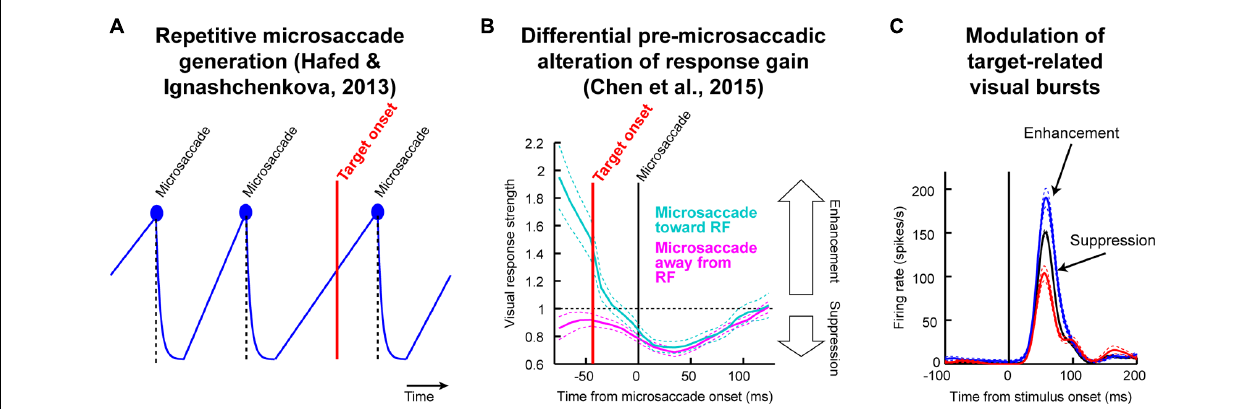
FIGURE 1 | Testing the theoretical implications of pre-microsaccadic changes in visual sensitivity. (A) During prolonged gaze fixation, microsaccades repetitively occur. This can be modeled as a repetitive rise-to-threshold process (Hafed and Ignashchenkova, 2013). If a peripheral target were to appear at a random time, it would necessarily appear at different times relative to microsaccade onset. (B) Peripheral target onset near microsaccades experiences altered visual sensitivity (Chen et al., 2015). Importantly, this effect is directionally dependent in the pre-movement interval (Hafed, 2013; Chen et al., 2015), such that visual sensitivity is enhanced if a target appears congruent with the upcoming microsaccade direction and suppressed if it is opposite the upcoming microsaccade. (C) The net result is that for an identical target onset, visual bursts can be either enhanced or suppressed as a function of microsaccade direction. Since response gain strength is a direct determinant of behavioral performance (Hafed et al., 2015), particularly for both saccadic and manual reaction times (RT’s), an important theoretical question to ask is: are these microsaccade-related changes sufficient to account for classic behavioral phenomena? In this study, we used a theoretical approach to investigate this issue for a specific type of task. We developed a model only implementing the two concepts in this figure (microsaccade repetitiveness and differential pre-microsaccadic changes in vision) and asked how much explanatory power it has. (B,C) Were modified with permission from (Chen et al.,